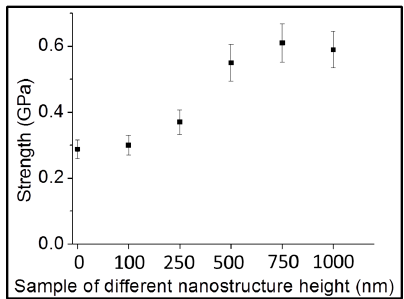
Figure 3. Comparison of bending strengths as determined by 3PB tests between plain (no